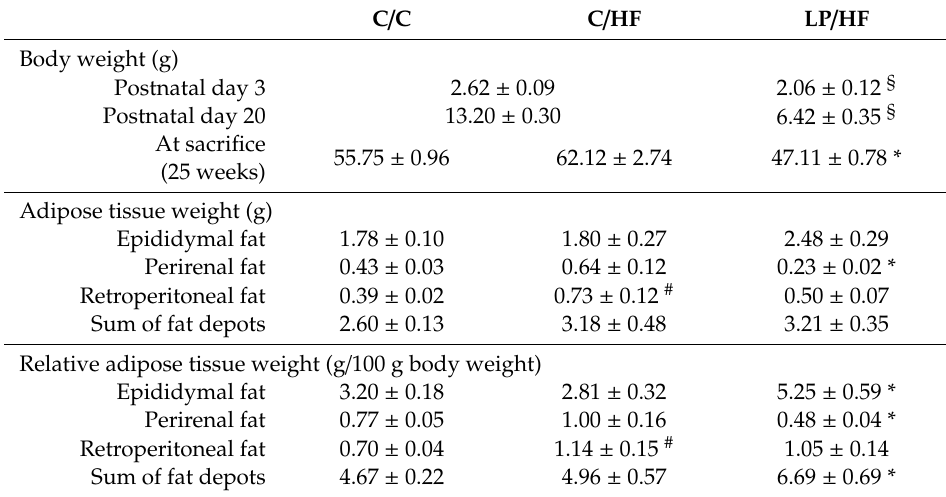
Table 1. E ff ects of maternal protein restriction during pregnancy and lactation on body and adipose tissue weights of male o ff spring fed a high-fat